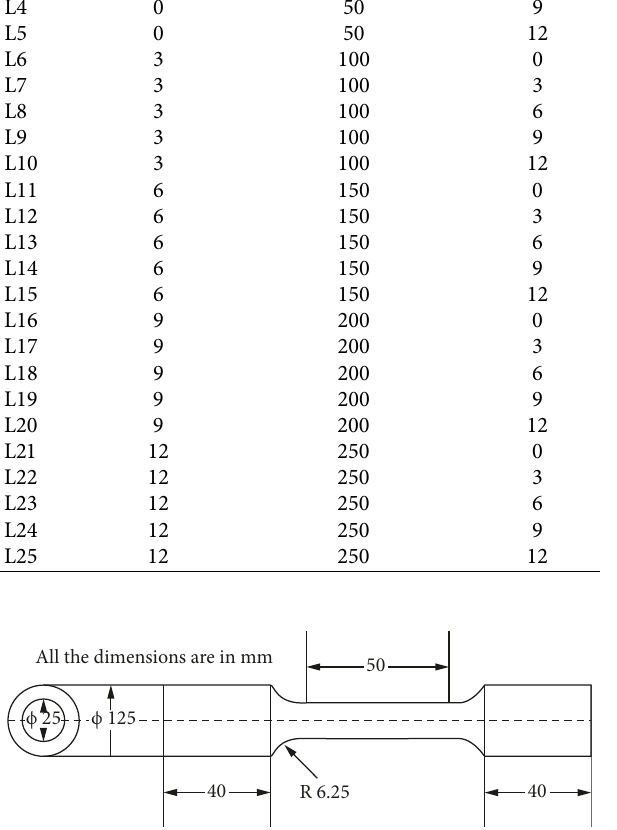
Figure 1: Schematic of a tensile test sample.